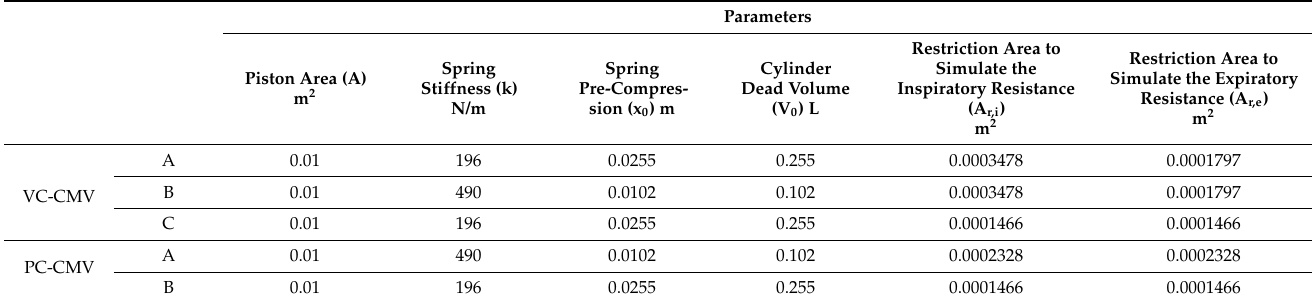
Table 10. Parameters set in the subroutine “Patient” concerning simulations of real-life cases of the Case